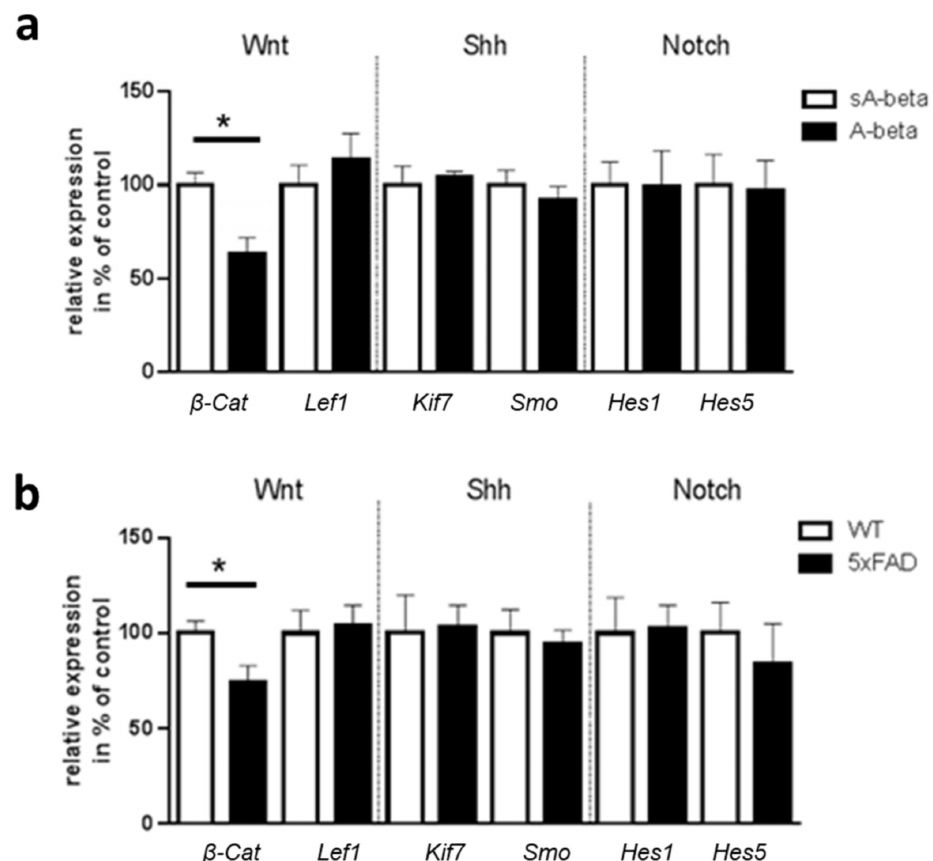
Figure 5. Effect of acute A-beta administration or of chronic exposure within transgenic enteric neurons on ciliary signaling pathways. ( a ) Enteric wild type neurons (DIV3) were treated for 24 h with A-beta peptides or scrambled control (sA-beta). mRNA was used for analysis of depicted gene products with Gapdh mRNA levels for normalization ( n = 6–8 per group). ( b ) Colonic mRNA of 8-month-old mice (WT or 5xFAD) was subjected to qPCR analysis. mRNA levels obtained were normalized to Gapdh mRNA levels ( n = 5–6 per group). Statistical analysis was performed by pairwise t -tests (* p < 0.05). All data are presented as mean +